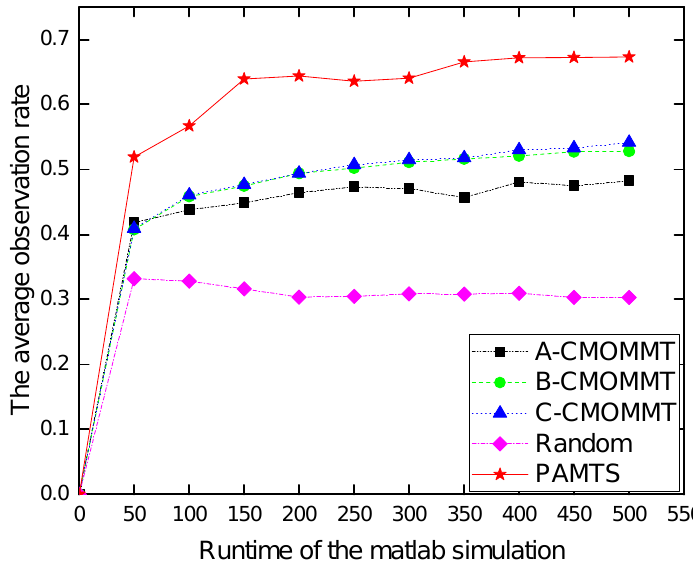
Figure 6. The saturation of the performance with increasing runtime under the condition that N / M =